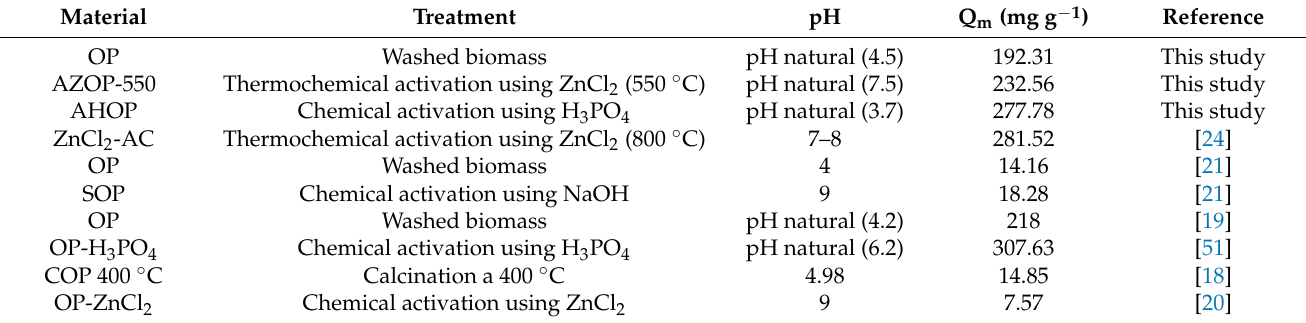
Table 5. Comparison of maximum adsorption capacities of MB on different